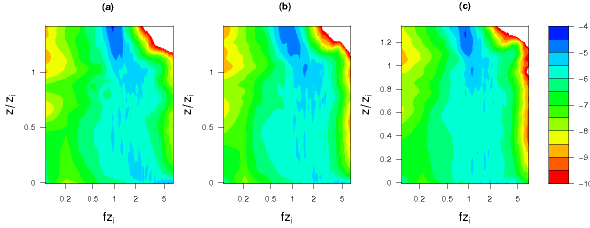
Fig. 11. Normalized copectra [P m] for the intermediate scale sur- face heterogeneity vertical velocity and air temperature for (a) low (b) medium and (c) high wind speed